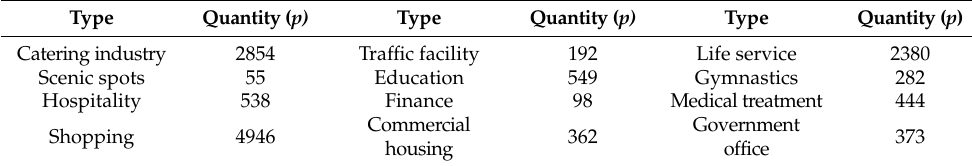
Table 1. Sorted POIs of Fengdong New Town.